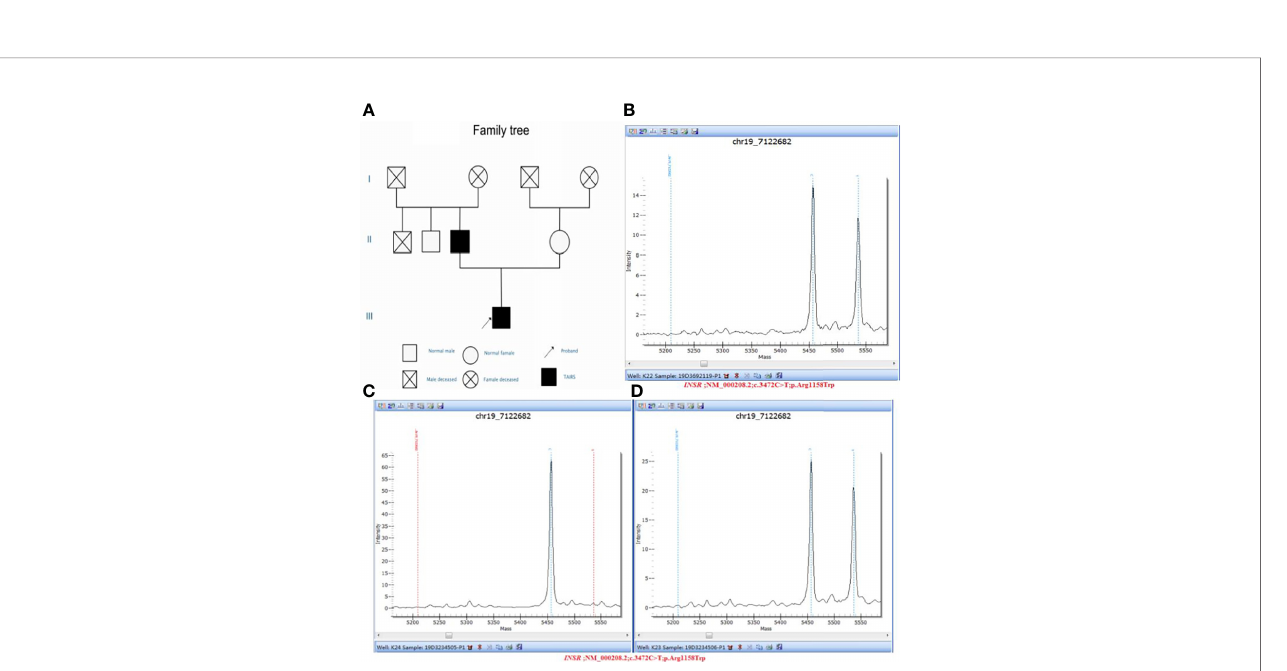
FIGURE 3 | (A) Pedigree diagram and veri fi cation results of genetic testing for the proband and his parents: (B) Sample number: 19D3692119, Af fi liation: proband, Nucleotide change: c.3472C>T, Amino acid changes: p.Arg1158Trp, Veri fi cation result: heterozygosis, Test method: Mass spectrometry validation; (C) Sample number: 19D3234505, Af fi liation: mother, Nucleotide change: normal, Amino acid changes: normal, Veri fi cation result: normal, Test method: Mass spectrometry validation; (D) Sample number: 19D3234506, Af fi liation: father, Nucleotide change: c.3472C>T, Amino acid changes: p.Arg1158Trp, Veri fi cation result: heterozygosis, Test method: Mass spectrometry